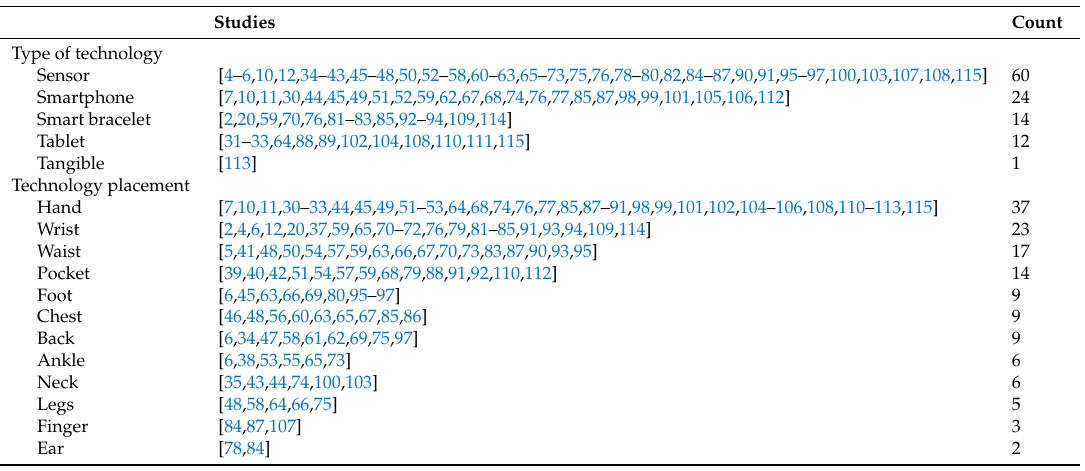
Table 3. Type, Placement and features for mobile technology used to monitor the health of older adults. Studies